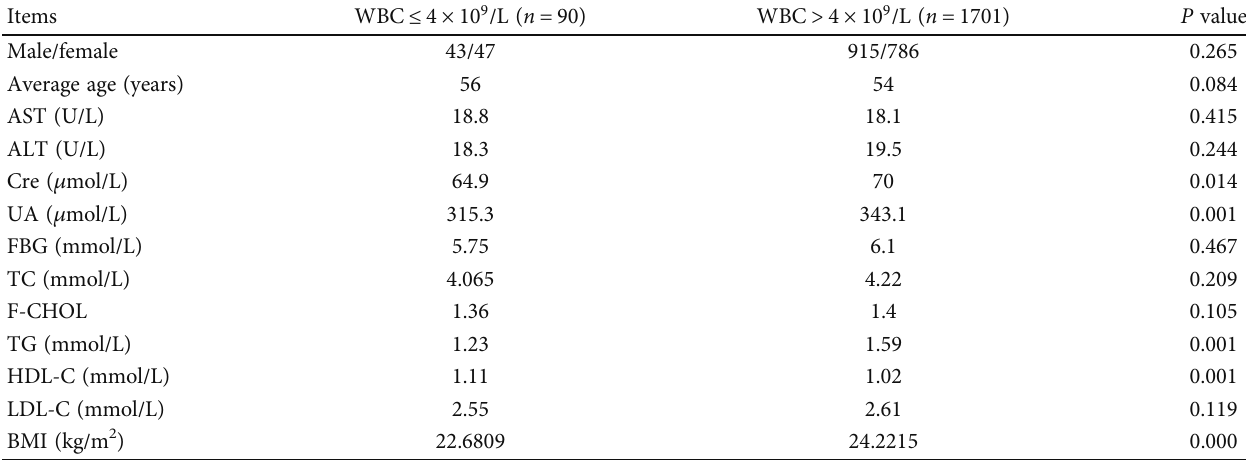
Table 1: Comparison of clinical data of patients in the WBC ≤ 4 × 10 9 /L and WBC > 44 × 10 9 /L groups.